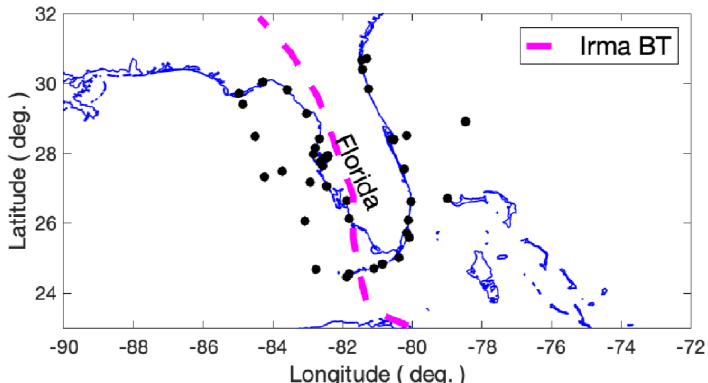
Figure 6. National Data Buoy Center (NDBC) observations near Hurricane Irma’s landfall, used for HWRF validation, are indicated by black dots. Magenta depicts Hurricane Irma’s best track.